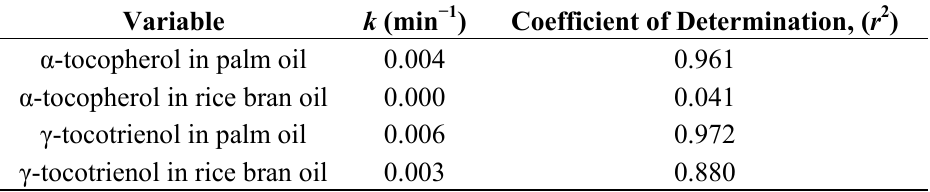
Table 1. Kinetic constant ( k ) of degradation of α-tocopherol and γ-tocotrienol and the coefficient of determination ( r 2 ) of palm oil and rice bran oil during